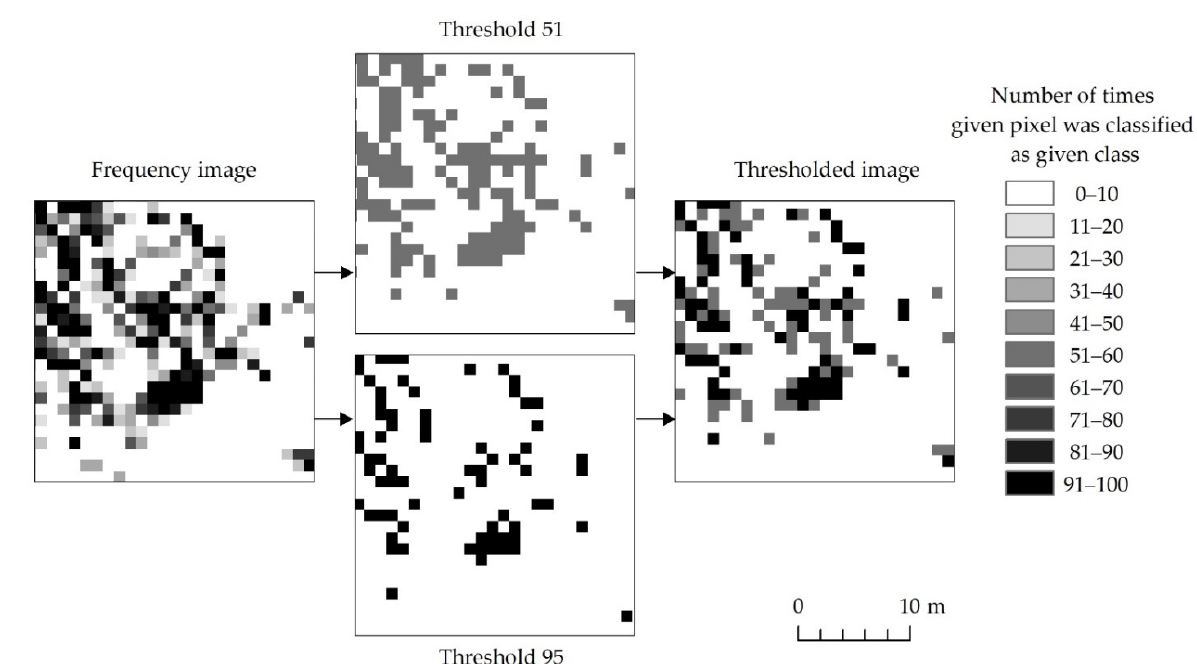
Figure 4. Pixels presenting an exemplary species depending on the number of iterations during the species was identified based on randomly selected training patterns during 100 classifications.